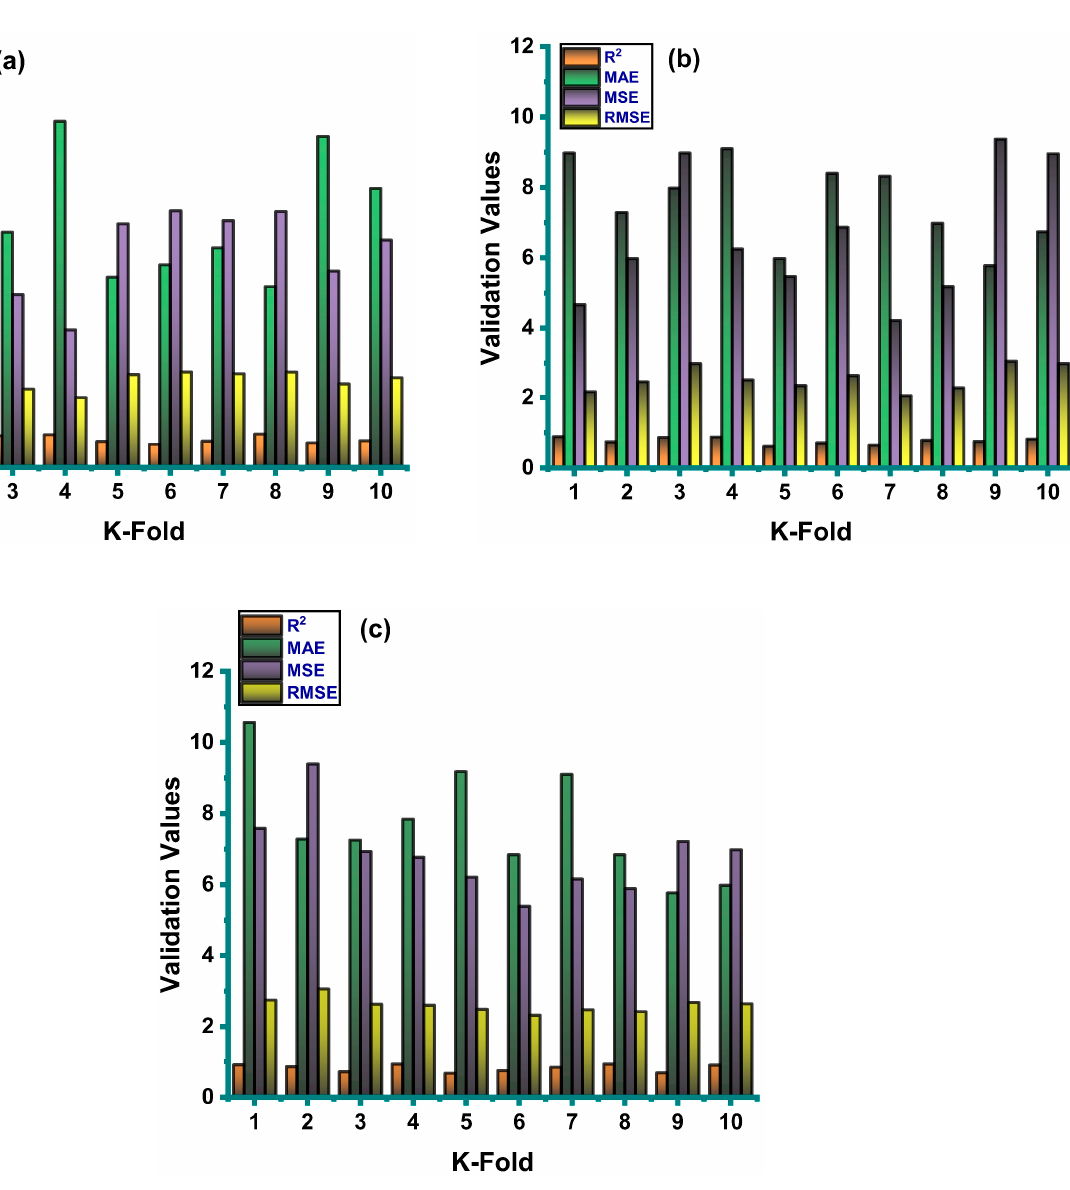
Figure 8. Statistical indicator for k-fold cross-validation. ( a ) GEP model. ( b ) ANN model. ( c ) DT model.